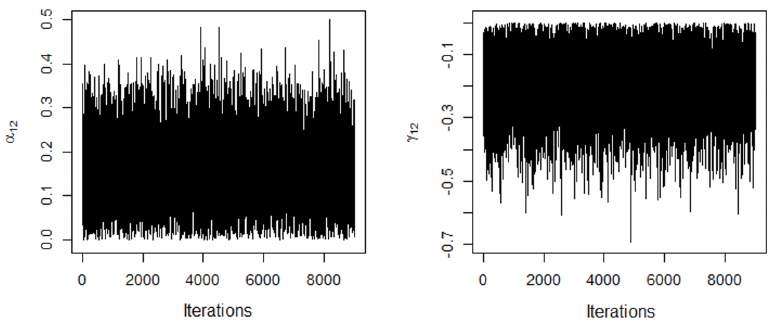
Fig 3. Traces of the chains for the first two coordinates of the genotype and environment singular vectors using the AMMIBS model, with restriction of sign for